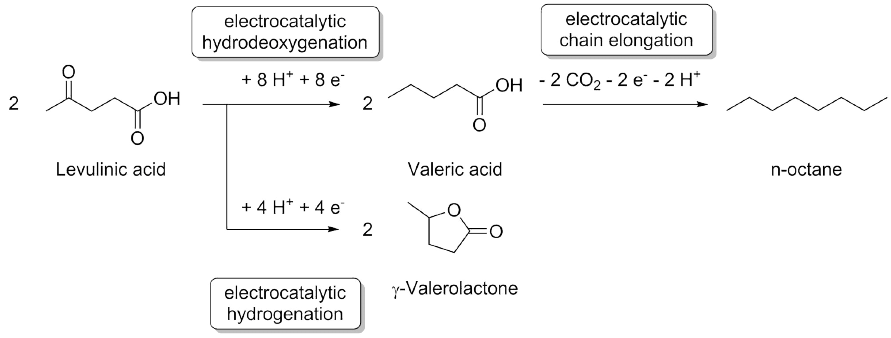
Figure 3. Electrochemical reaction pathway for the n-octane production [52].